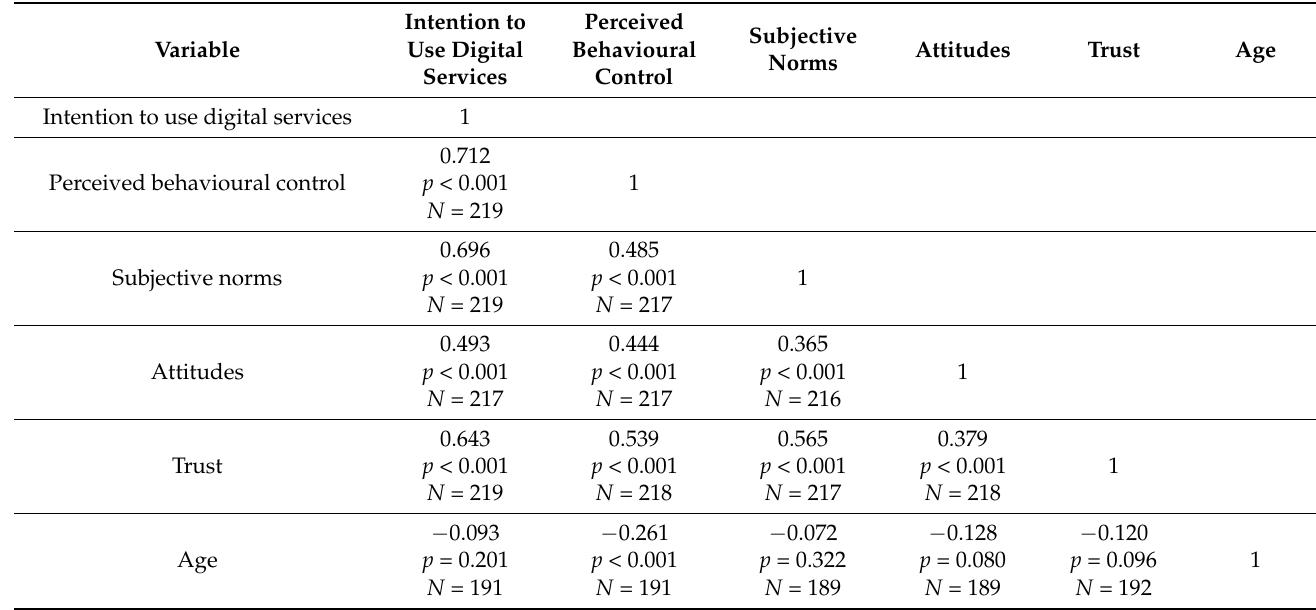
Table 3. Pearson correlations.